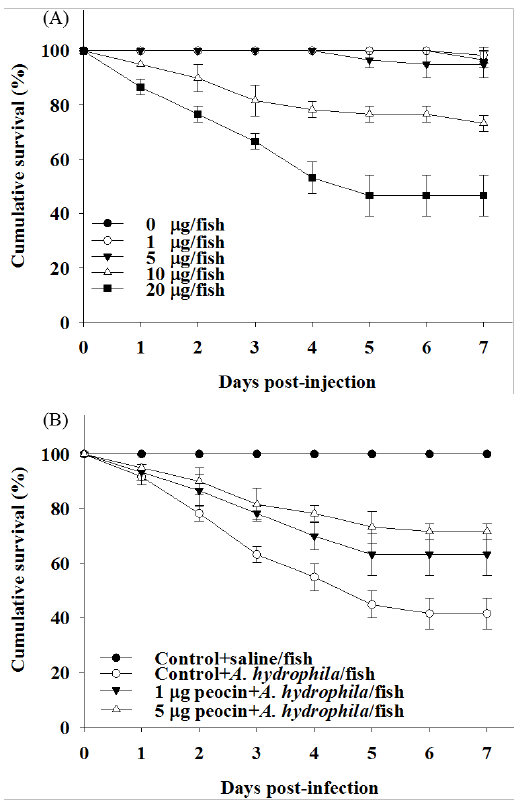
Figure 6. Cumulative survival of zebrafish injected with ( A ) various concentrations of purified peocin and ( B ) A. hydrophila . The daily survival rate of each group is recorded and is presented as the mean ± standard deviation (SD) from triplicate experiments. Table 2. Antimicrobial activity of purified peocin and antibiotics against diverse pathogens. 254